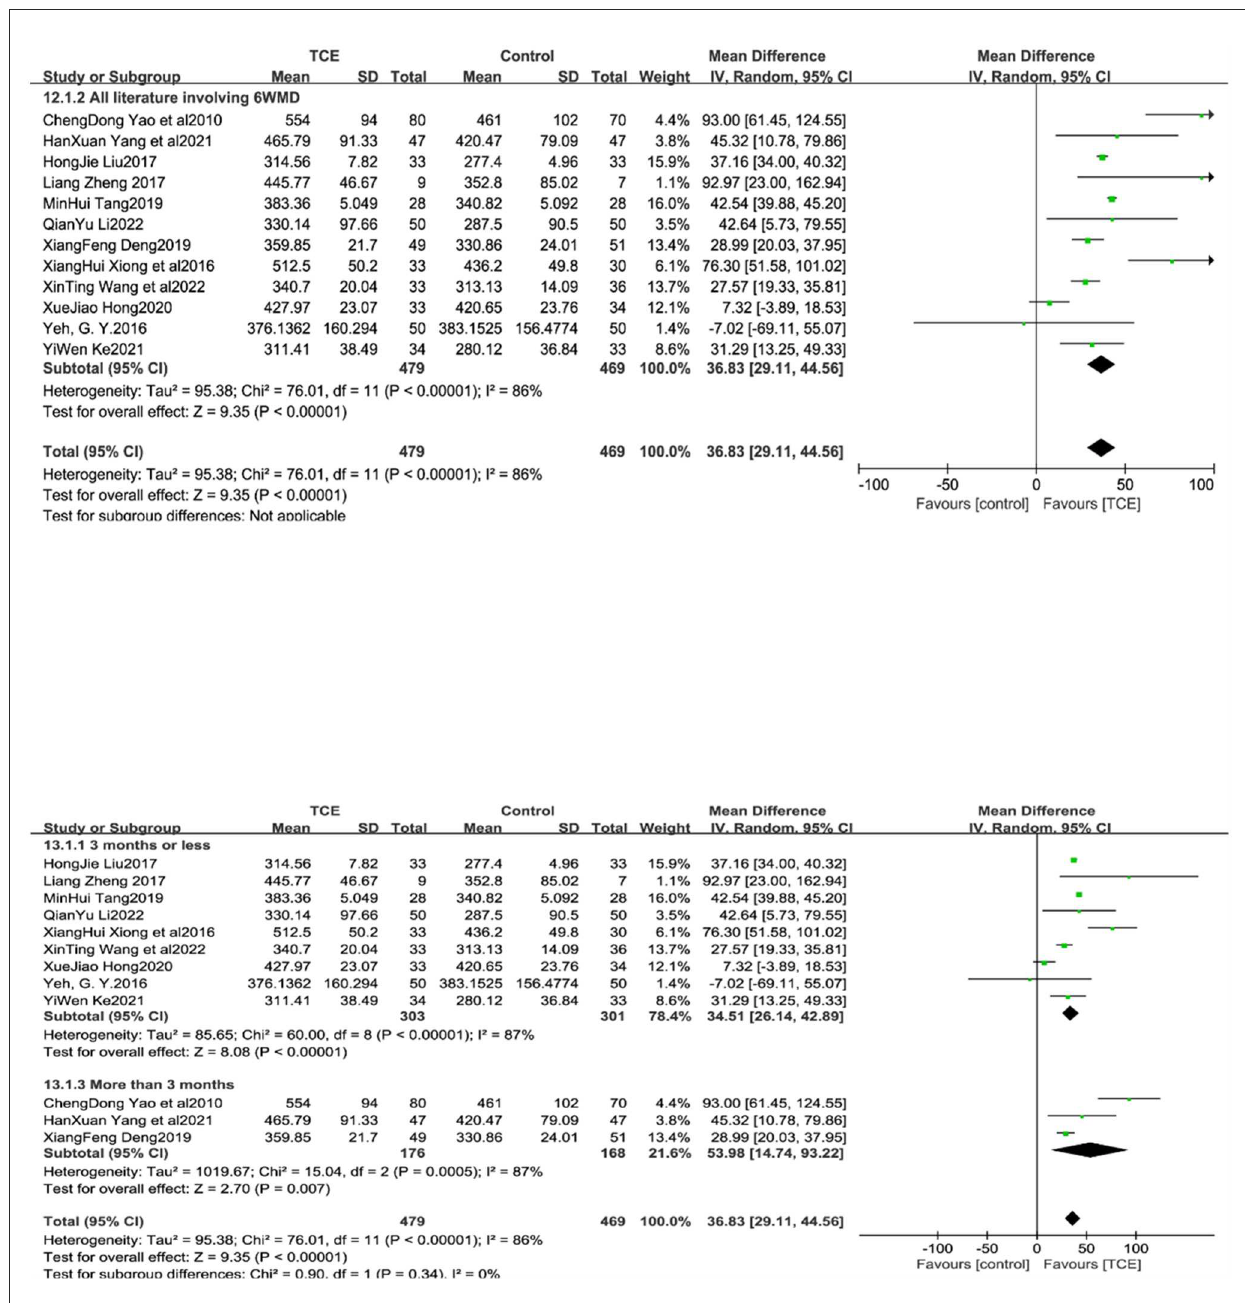
FIGURE9 The effect of Traditional Chinese exercises on patients’ 6MWD (included subgroup